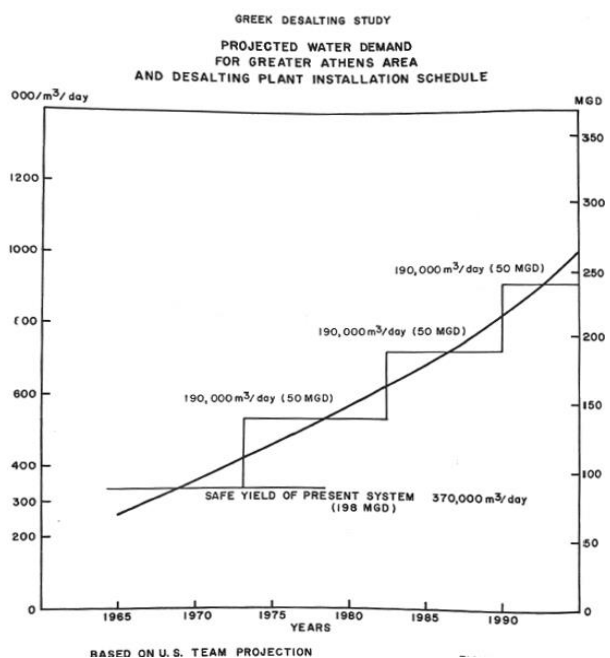
Figure 2: Water demand projections considering the installation of increasing desalting capacity for the OSW’s 1966 Athens, Greece Water Study